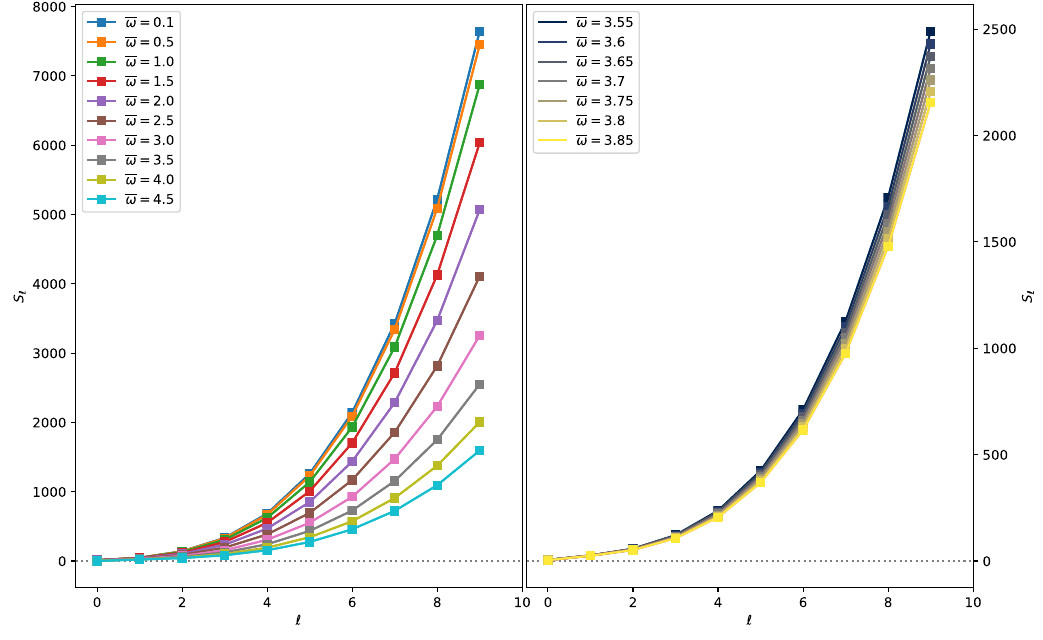
Figure 2. Left: evaluating T ‘ for a tachyon with m 2 = − 1 . 0 . Right: the behaviour of S ‘ near ω 0 = ∆ + ≈ 3 . 7